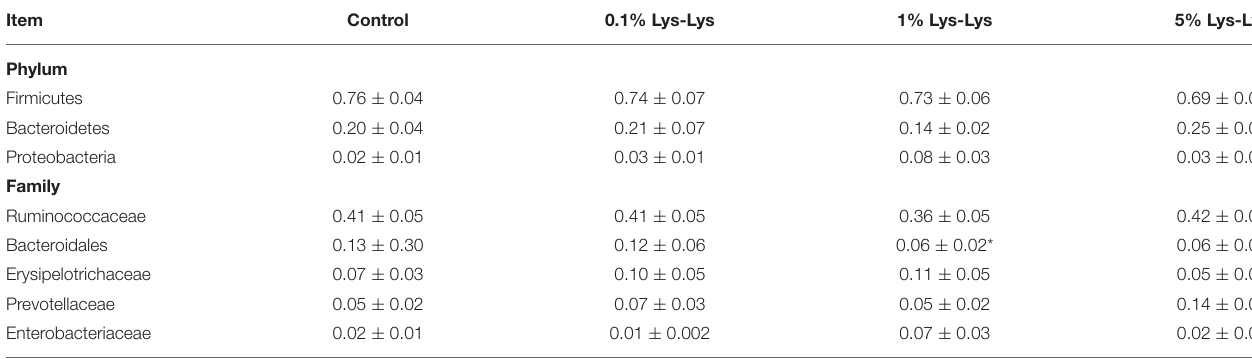
TABLE 4 | Effect of Lys-Lys on bacteria at the phylum and family levels in piglets a .